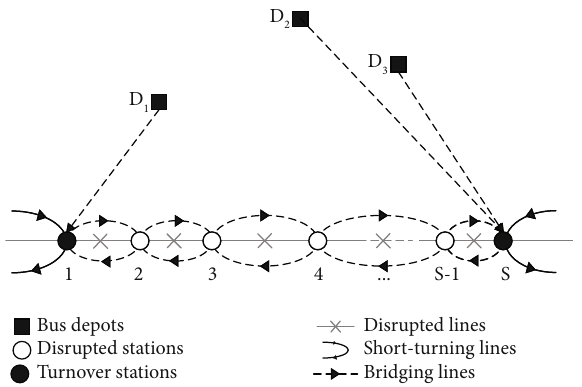
Figure 2: Traditional bus bridging